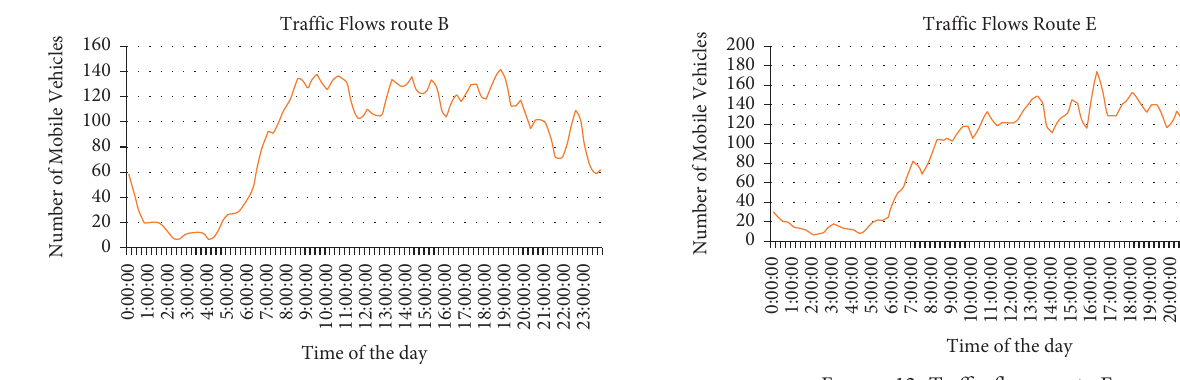
Figure 9: Traffic flow: route B.